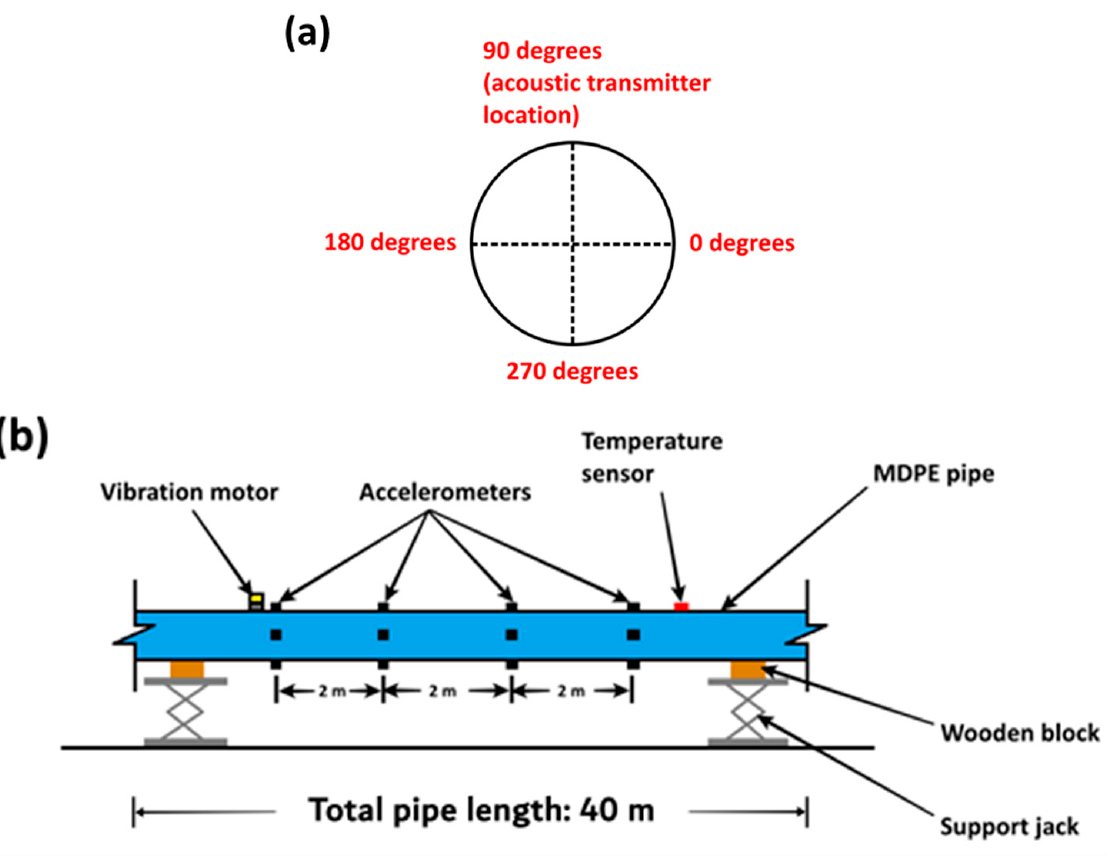
Figure 3. ( a ) Pipe cross-section indicating the acoustic transmitter location and ( b ) schematic of the exposed MDPE pipe (not to scale) in the